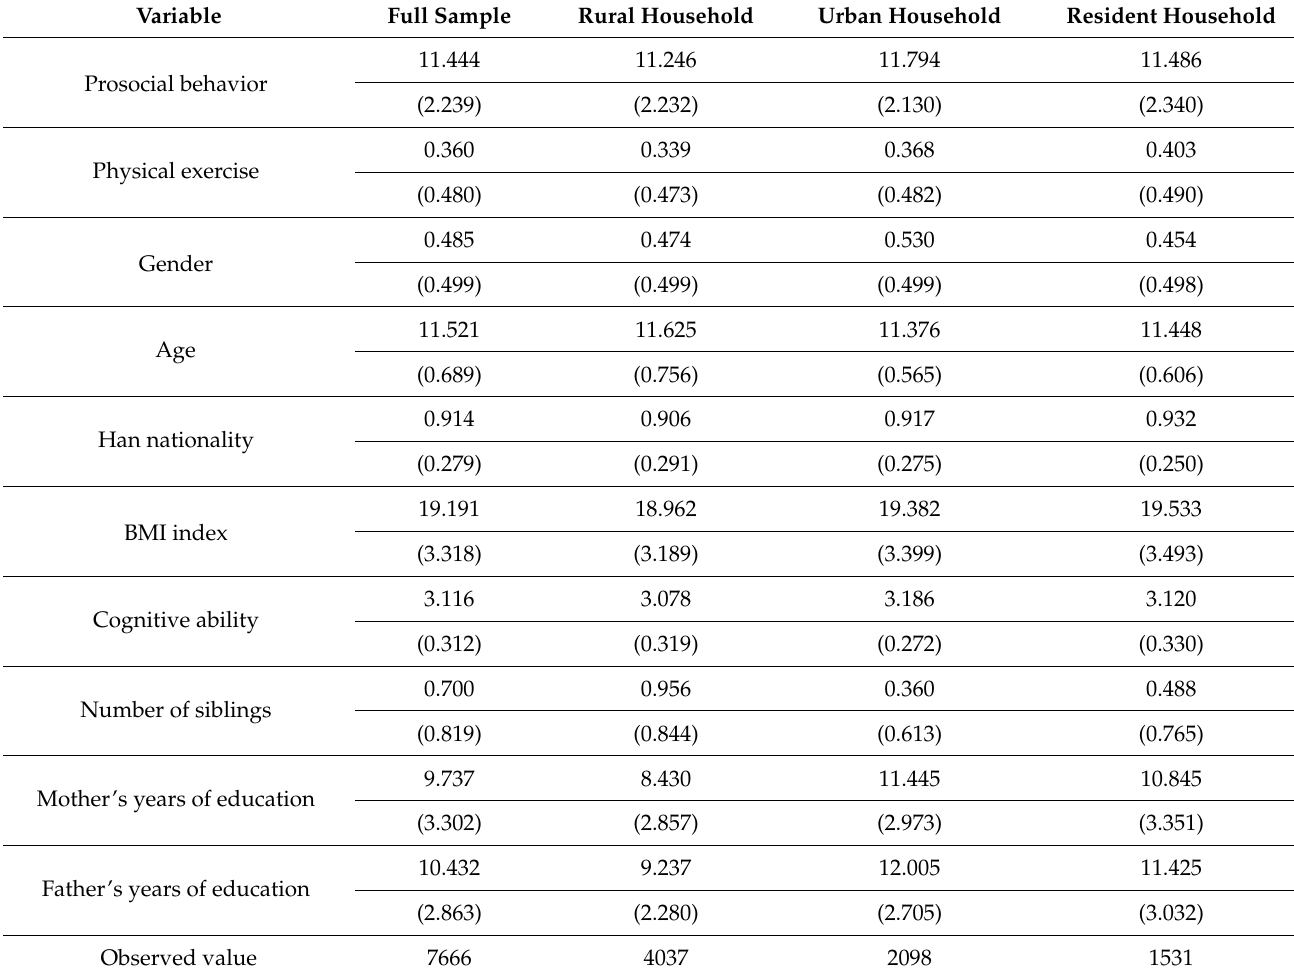
Table 1. Statistical description of the analyzed